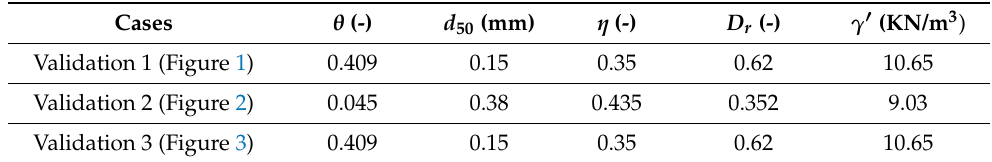
Table 1. Summary of sediment parameters used for model validation. θ denotes shields paramter, d 50 denotes median grain size, η denotes porosity, D r denotes relative density, and γ (cid:48) denotes submerged unit